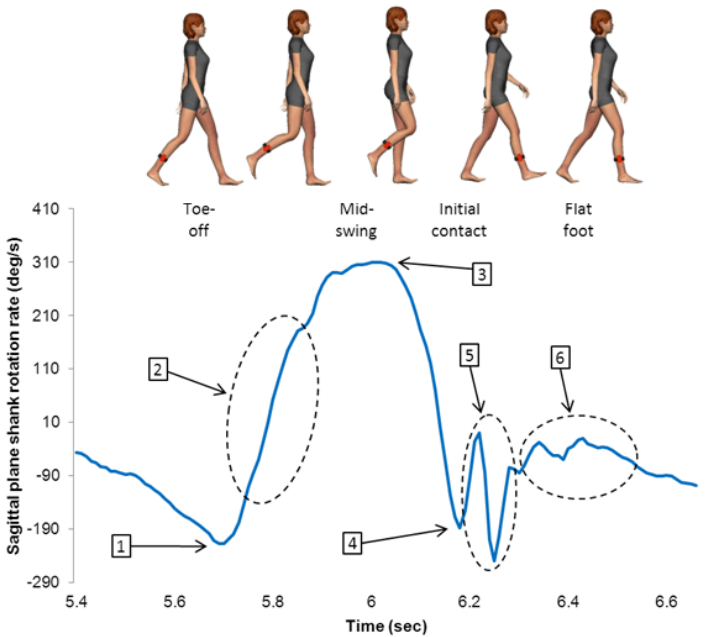
Figure 1. The sagittal plane shank gyroscope signal over a single gait cycle. The quantified features from each gait cycle are numbered on the graph. 1 — minimum value at